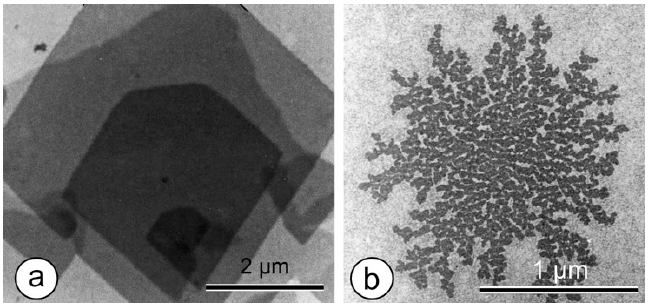
during the reassembly process. ( b ) Fractal-like structures are formed by SbpA when the calcium ion